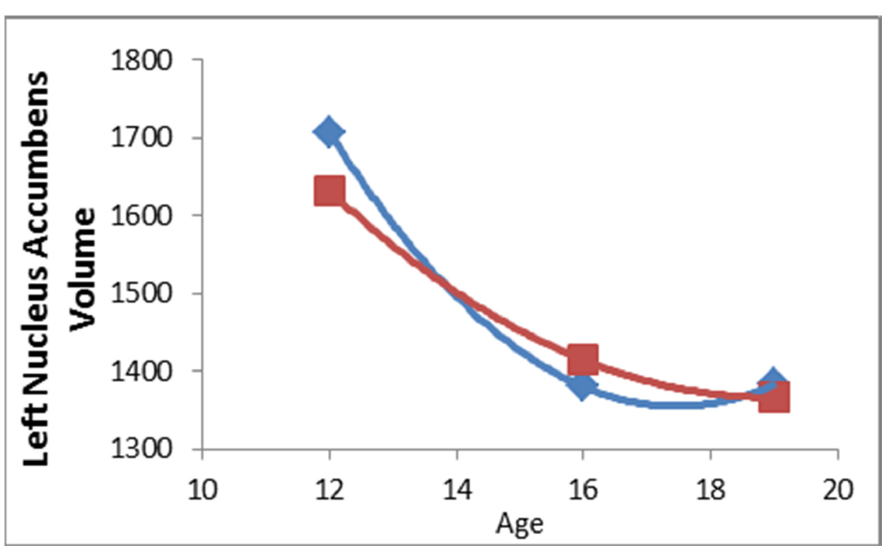
Fig 3. Mother aggressive behavior by quadratic age interaction for male left nucleus accumbens volume. Data points represent predicted volume at each time point, and red and blue lines represent fitted age curves, for adolescents with high and low aggressive mothers,